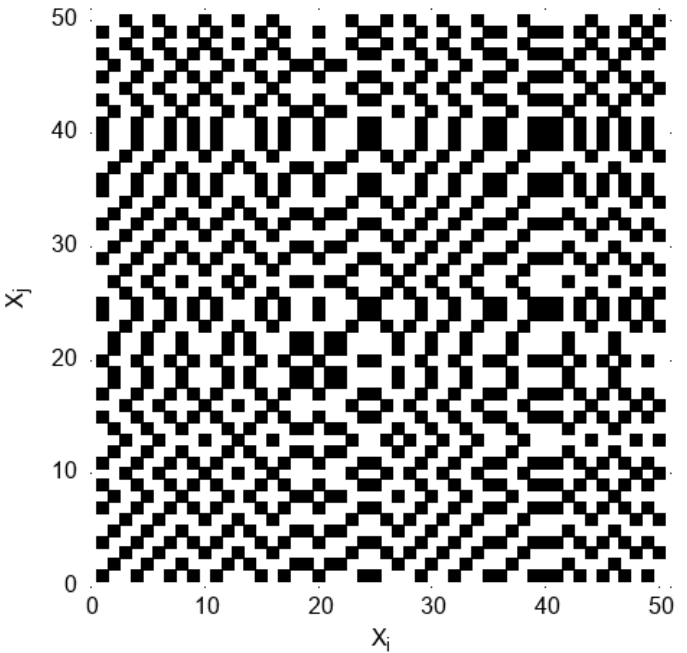
Figure A1. Example recurrence plot for RPS time series